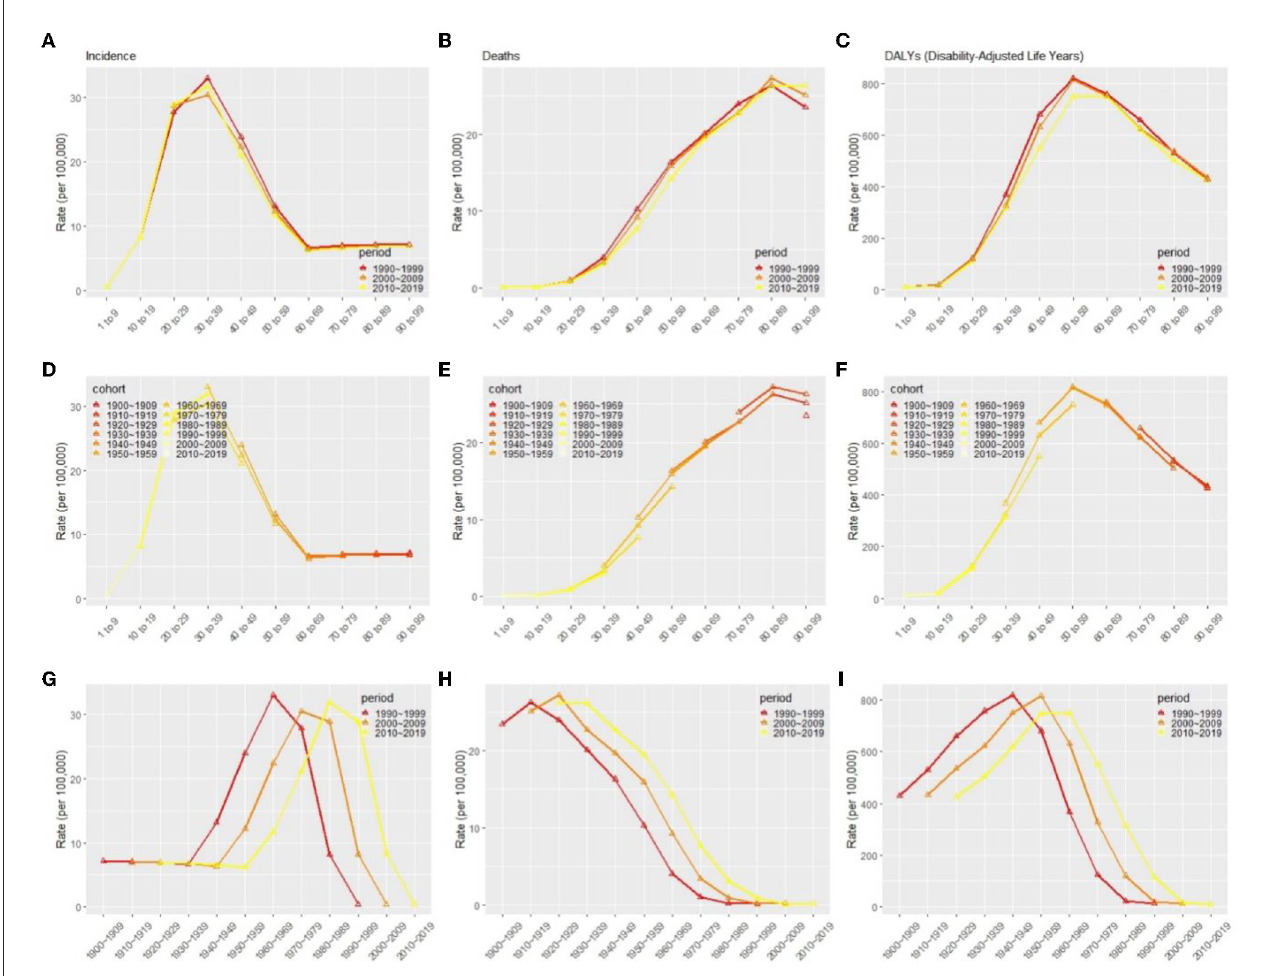
FIGURE7 Effects of age (A–C) , period (D–F) , and cohort (G–I) on incidence rate, death rates, and DALYs in patients with multiple sclerosis globally, respectively. DALYs, disability-adjusted life